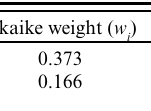
) predicting percent of survey visits where Willow Flycatchers ( Empidonax c